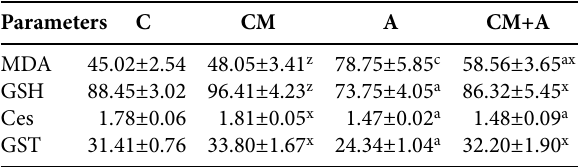
Table 2: MDA, GSH and enzyme activity levels of the liver. GST and Ces activities are expressed as nmol/min/mg protein ± mean stand- ard error. GSH and MDA levels are expressed as nmol GSH/mg pro- tein ± mean standard error, and nmol MDA/g wet weight tissue ± mean standard error,